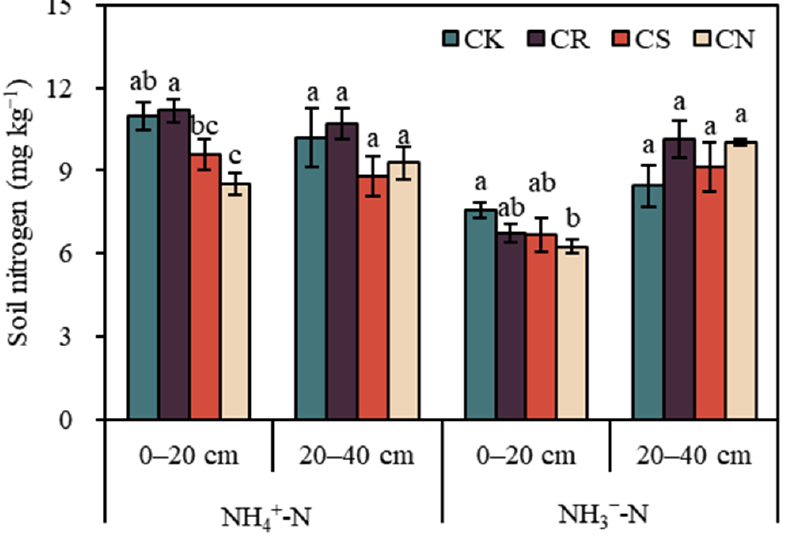
Figure 9. Soil NH 4+ ‐ N and NO 3 − ‐ N content at the 0–20 cm and 20–40 cm soil depths as affected by tillage regimes in 2021. CK, rotary tillage without straw returning; CR, rotary tillage with straw incorporation; CS, subsoiling tillage with straw mulching; CN, no tillage with straw mulching. Bar means the standard error. Different letters among the treatments indicate a significant difference at p < 0.05.